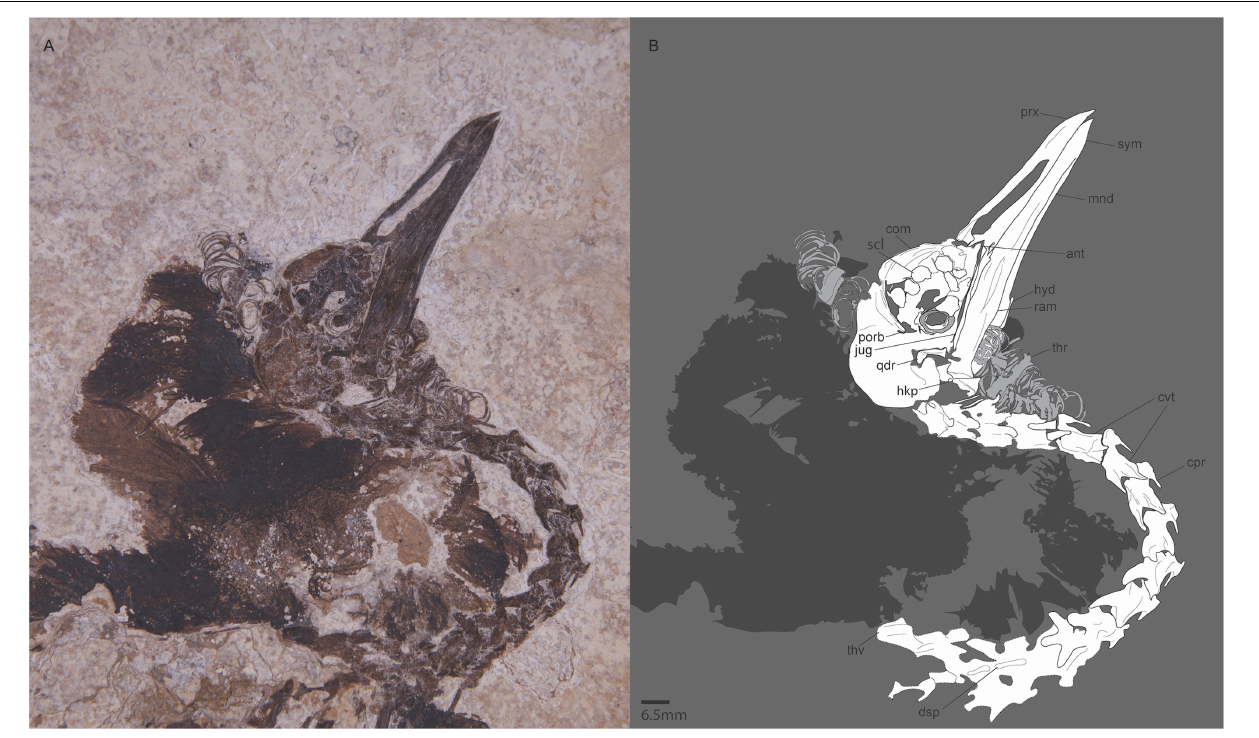
FIGURE 2 | Photograph (A) and line drawing (B) of the head and neck of FMNH PA778. Bone is unfilled, matrix is gray, cartilaginous tracheal and possible syringeal rings are shown in light gray, and feathers and other unidentifiable soft tissue is displayed in dark gray. Extremely crushed bone and bone margin is delimited with dashed margins. Anatomical abbreviations: prx, premaxilla; com, crest-like orbital margin; ant, antorbital angle; scl, scleral rings; porb, postorbital process; qdr, quadrate; mnd, mandible; hkp, hook-like process; ram, mandibular ramus; sym, symphysis; jug, jugal; hyd, hyoid; cvt, cervical vertebrae; cpr, costal processes; thv, thoracic vertebra; dsp, dorsal spinous process; thr, tracheal